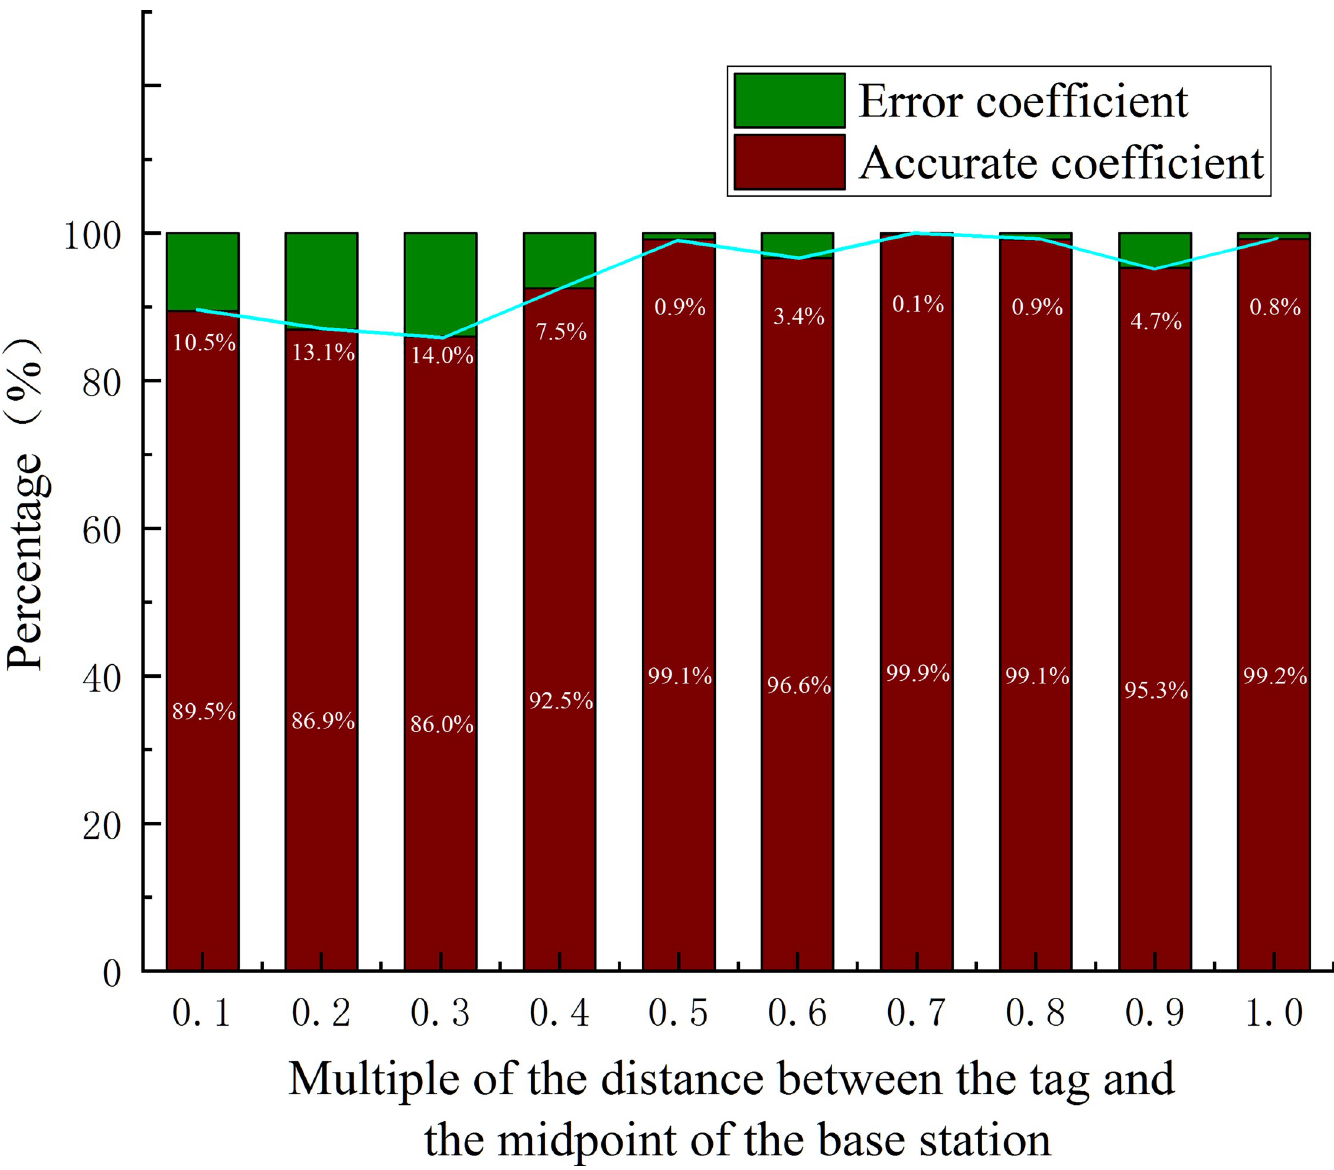
Fig 6. Error in experiment